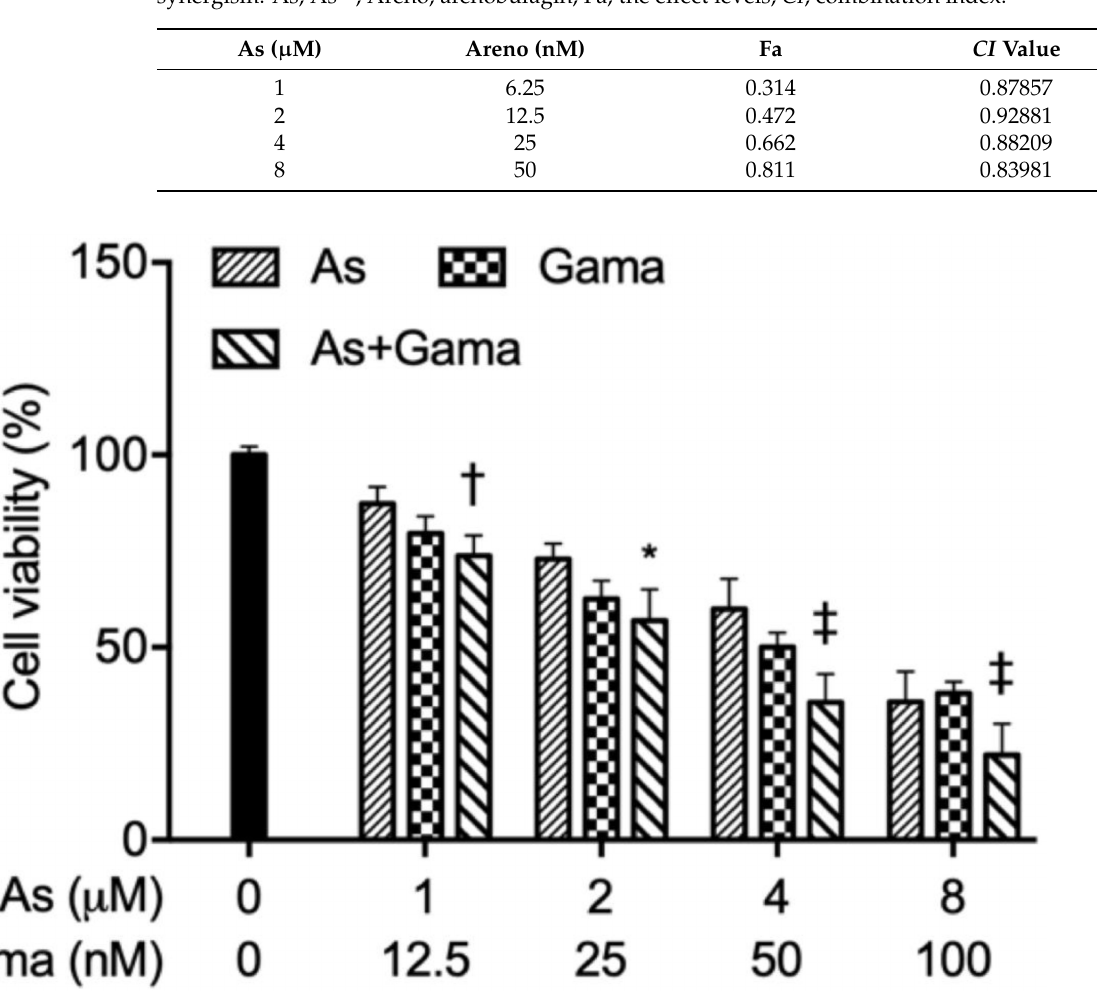
Figure 3. Enhanced cytotoxic effect of As III and gamabufotalin in U-87 cells. U-87 cells were treated with the combination of As III and gamabufotalin at a constant ratio (1 µ M As III + 12.5 nM Gama, 2 µ M As III + 25 nM Gama, 4 µ M As III + 50 nM Gama, 8 µ M As III + 100 nM Gama). Following treatment for 48 h, cell viability was determined by CellTiter-Glo Luminescent Cell Viability assay. Relative cell viability was calculated as the ratio of the luminescence intensity of each treatment group against those of the corresponding untreated control group. Data are shown as the means ± SD from more than three independent experiments. *, p < 0.05; †, p < 0.01; ‡, p < 0.0001 vs. each alone. As, As III ; Gama,